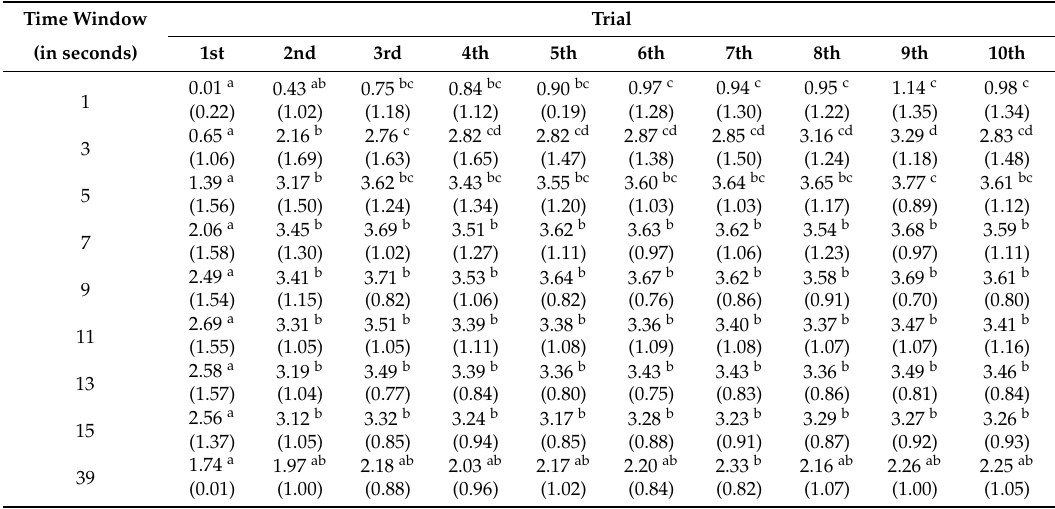
Table 2. Multiple comparisons of paired trials for the significant simple main effects of trial number in each time window.